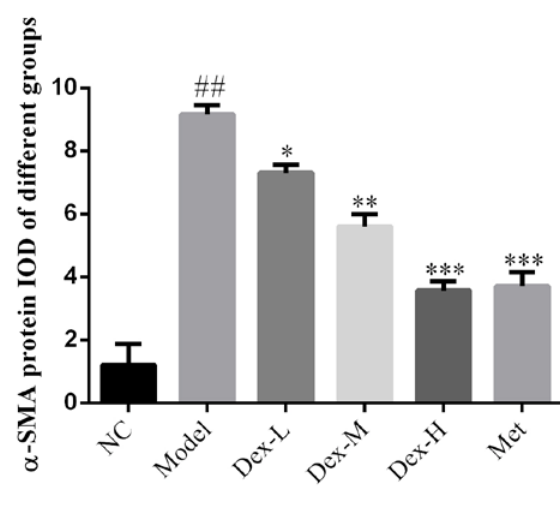
Figure 11: Comparison of α-SMA protein expression in Kidney of Rats in Each Group NC: normal control group; Model: DN model group; Dex-L: Dex low- dose treated group; Dex-M: Dex medium-dose treated group; Dex-H: Dex high-dose treated group; Met: Metformin treated group ##: P<0.01, compared with NC group; *: P<0.05, **: P<0.01,*** : P<0.001, compared with Model